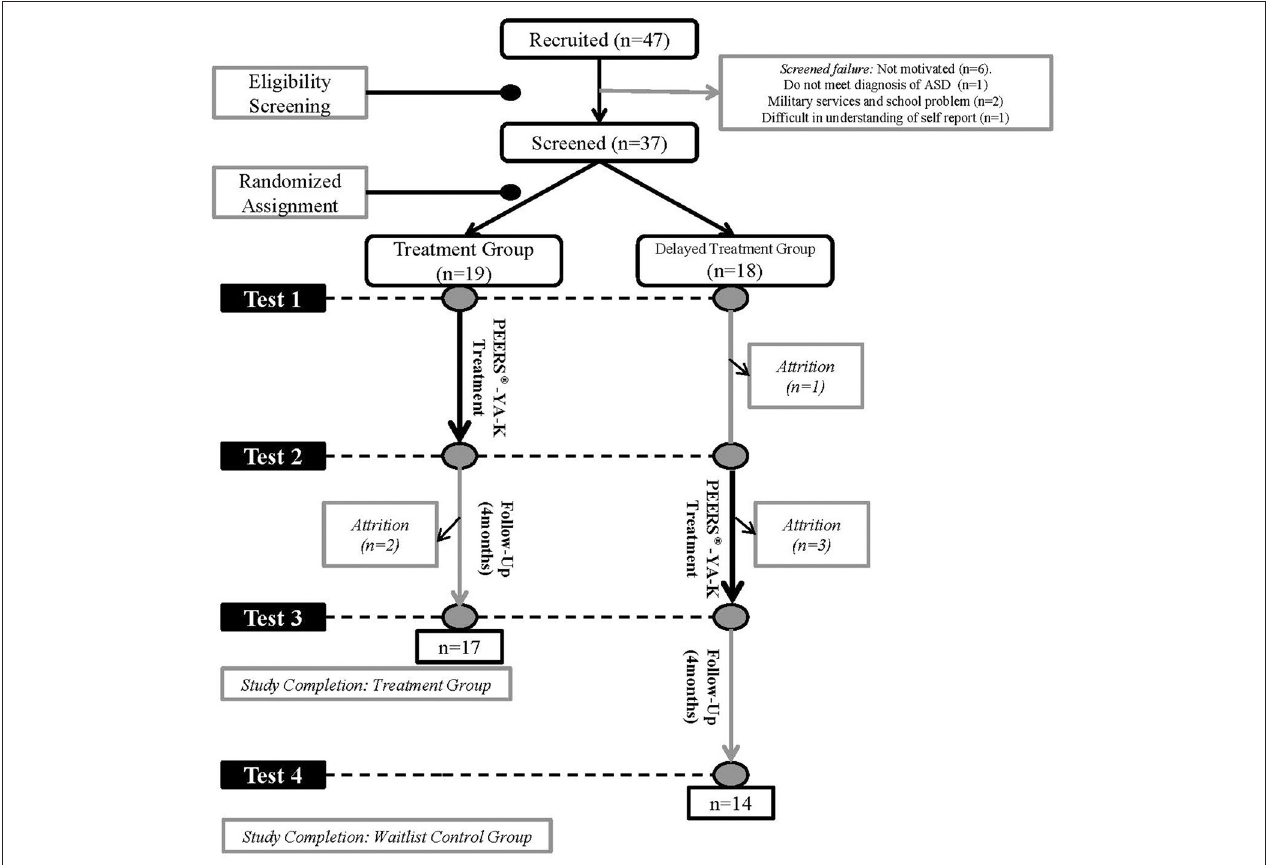
FIGURE 1 | Subject recruitment, assignment, and assessment